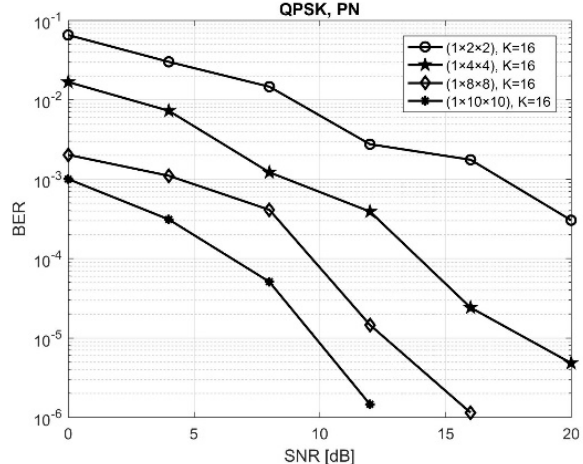
Figure 8. BER vs. SNR for a (1 × 2 × 2), (1 × 4 × 4), (1 × 8 × 8), and (1 × 10 × 10) MIMO configuration, QPSK modulation, cPN with 16 active users.